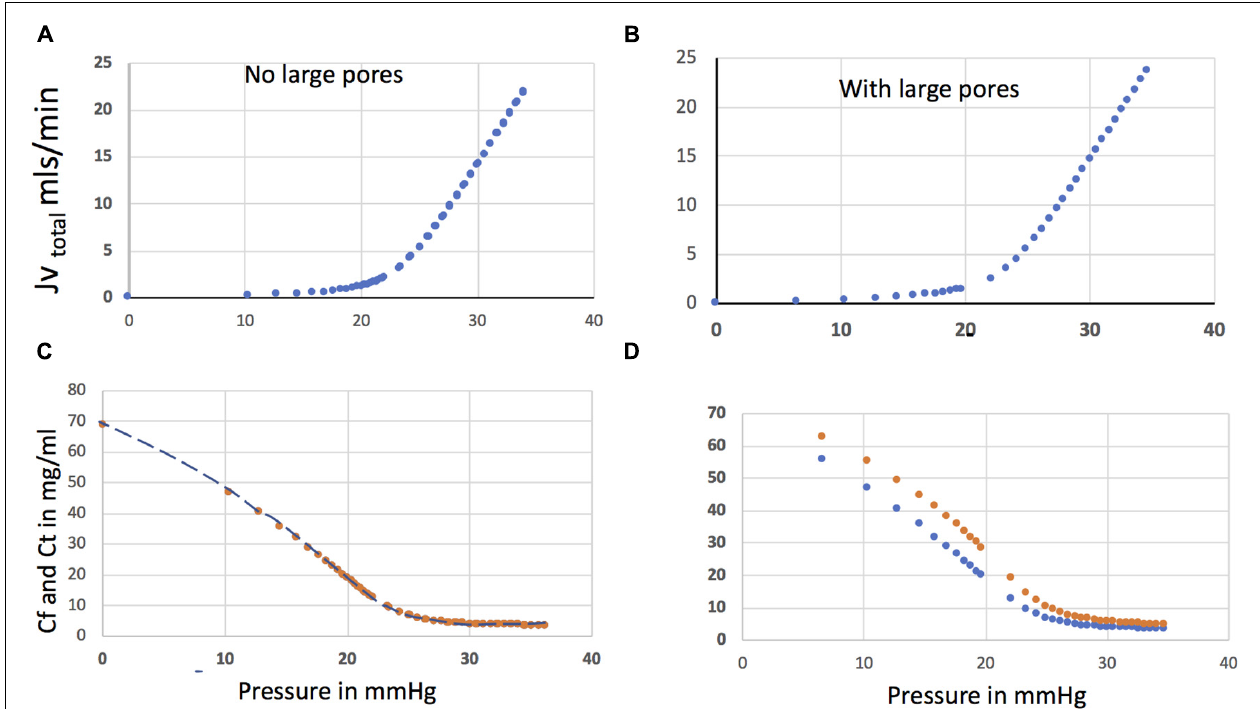
FIGURE 3 | Steady state relations between Jv Total ( Jv 1 + Jv 4) and Pressure [top panels (A) and (B) ] with and without large pores. The lower panels of Figure 3 show the concentration of plasma protein below the glycocalyx ( Cf ) (blue) and in the interstitial fluid ( Ct ) (red) as a function of capillary pressure with and without the presence of large pores. These relations are independent of the size of the ISF as the steady state ISF concentration is determined only by the relation Ct = Js Total / Jv Total . Many hours are required to establish steady state. Panel (C) shows that in the absence of large pores the ISF fluid has the composition of the fluid leaving the base of the glycocalyx. When the flux through large pores also mixes with the ISF ( D ) there is a difference in concentration between the fluid leaving the base of the glycocalyx and the tissue fluid.